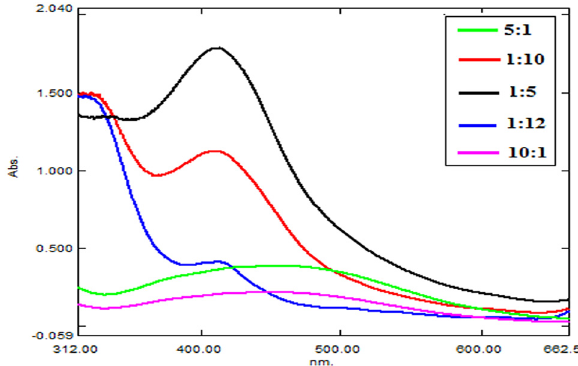
Figure 1: Comparison of UV - Vis spectra of V. jatamansi shoot AgNPs synthesized in di ff erent samples.